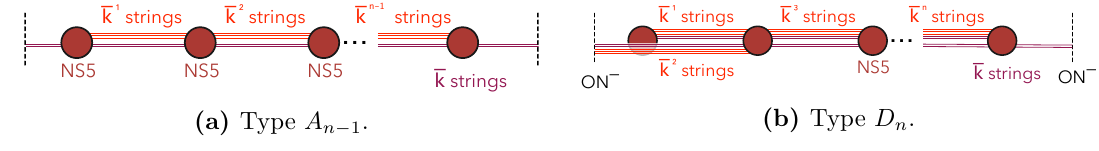
Figure 1 . Fractional and full strings in N = (2 ; 0)